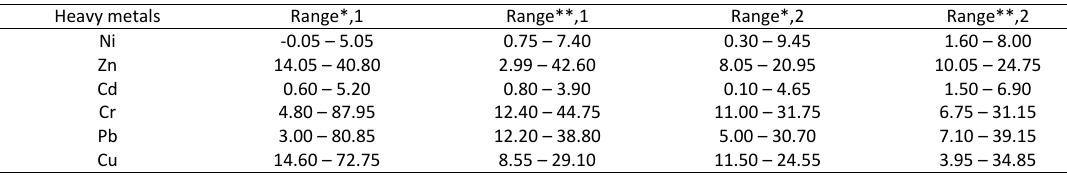
Table 3: Ranges of heavy metals (mg/kg) concentration in the study area